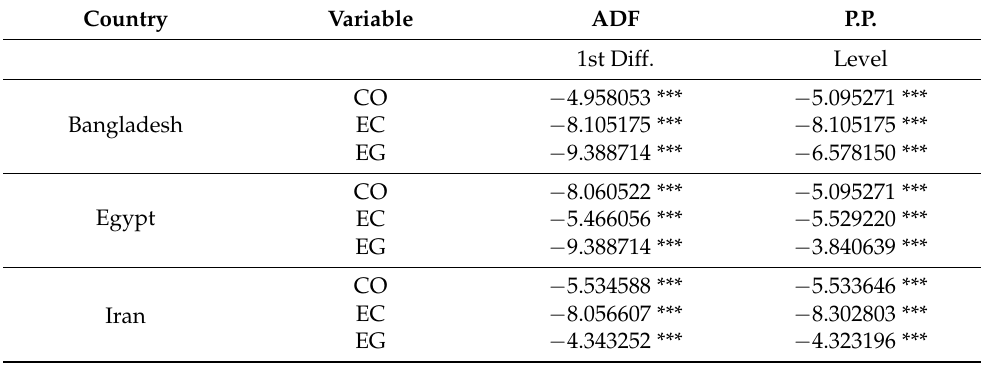
Table 3. Results for the unit root test.